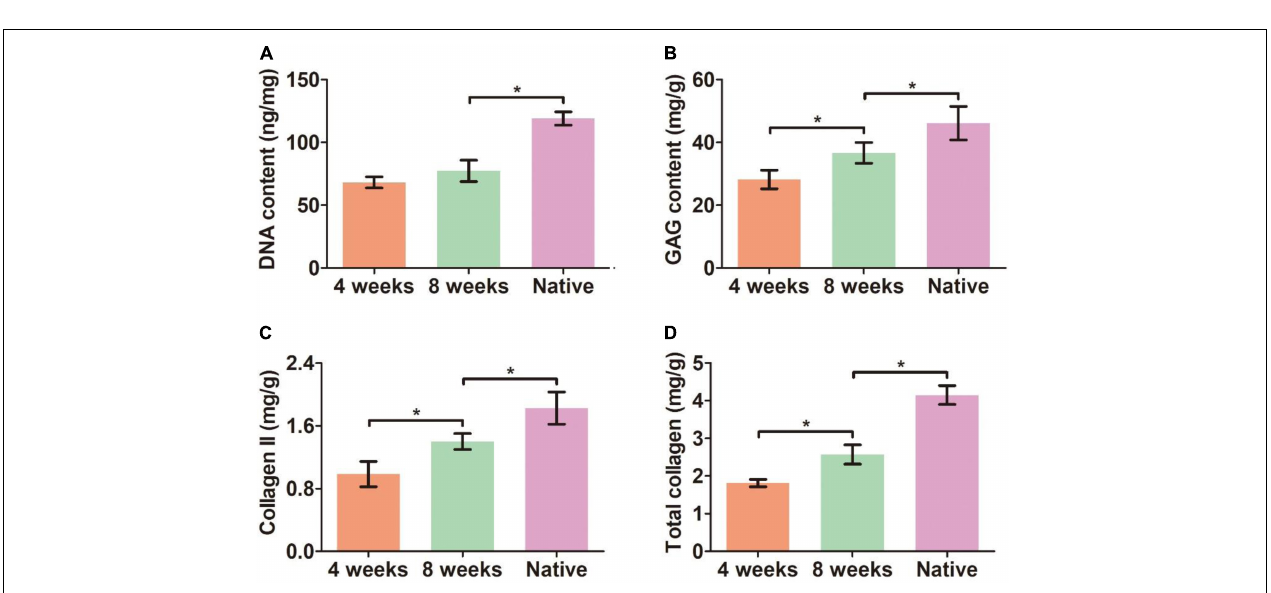
FIGURE 9 | Quantitative analyses of the biomimetic trachea after tracheal replacement. DNA content (A) , GAG content (B) , collagen II content (C) , and total collagen content (D) of the biomimetic after tracheal replacement for 4 and 8 weeks. N = 3 per group. * P < 0.05.